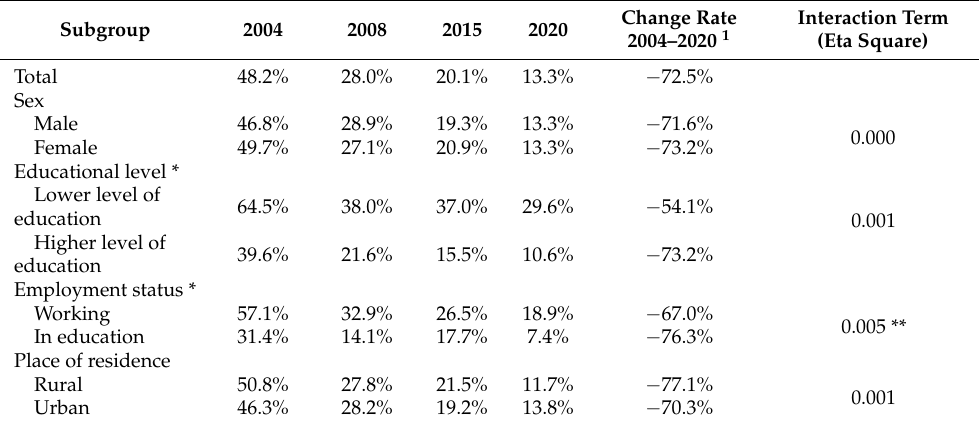
Table 2. Prevalence of daily smoking in different subgroups of adolescents and young adults